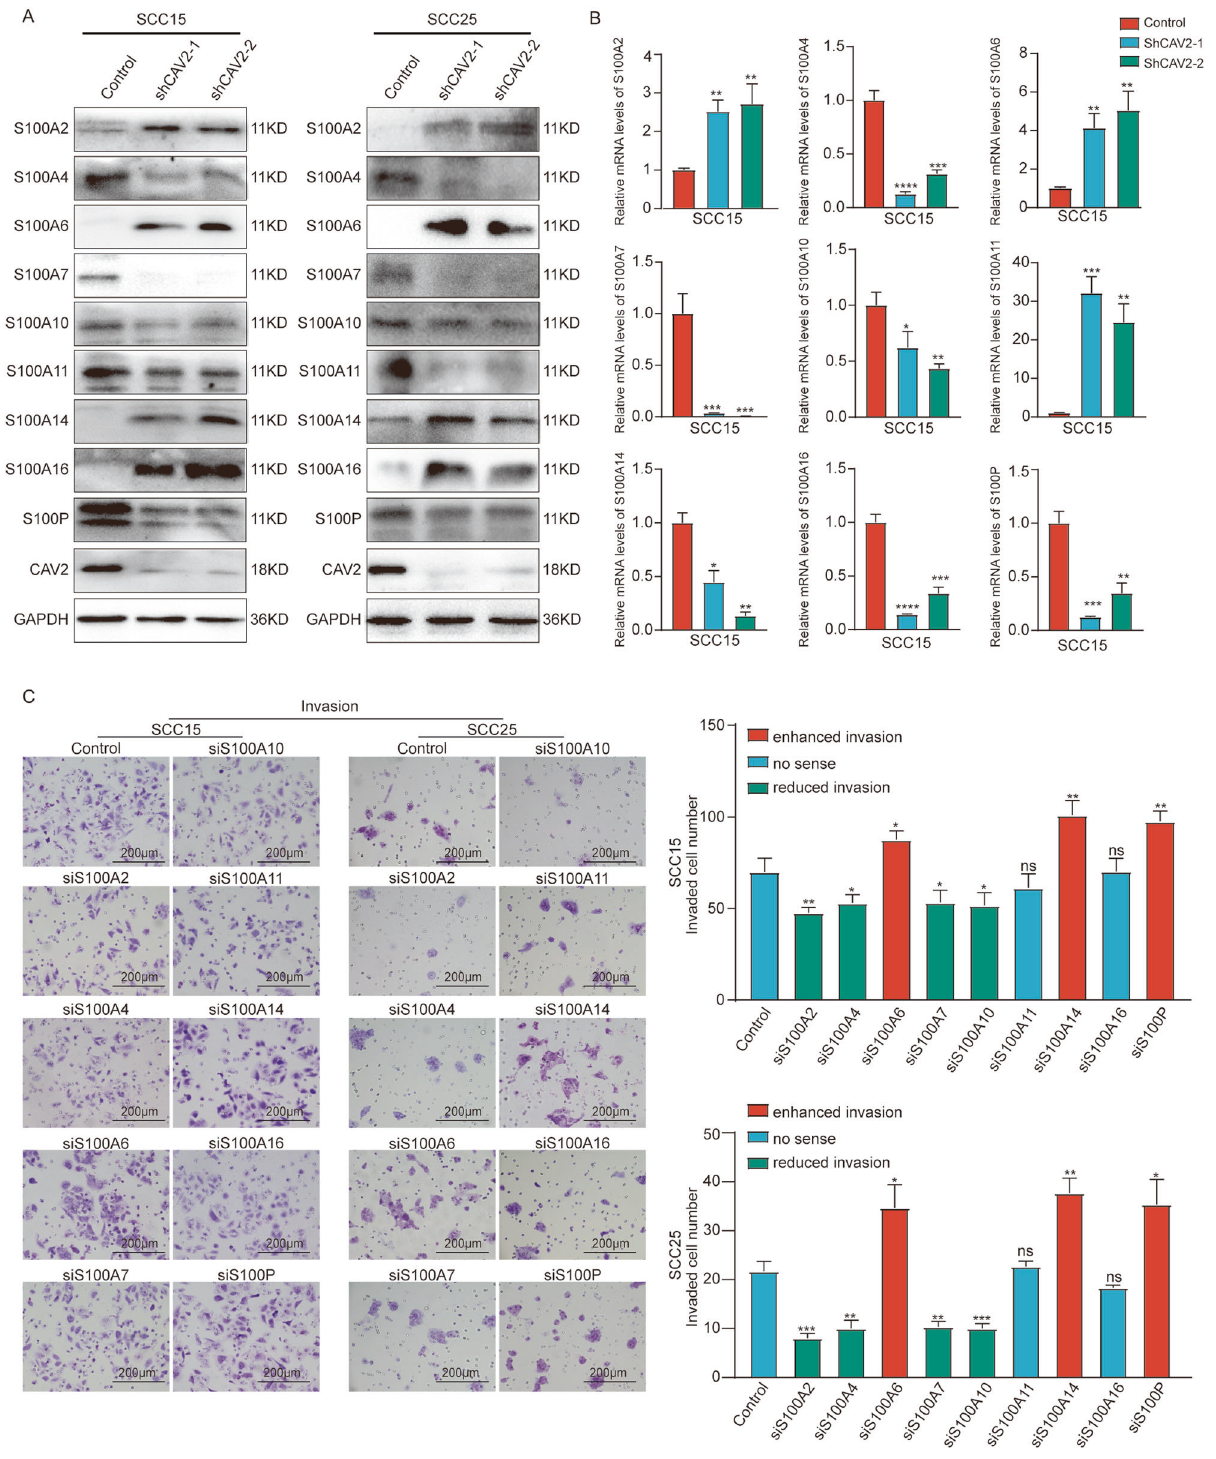
Fig. 3 The S100 protein family affects HNSCC metastasis and is regulated by CAV2. A The expression of S100 family proteins in CAV2- control and CAV2-knockdown (shCAV2-1, shCAV2-2) SCC15 and SCC25 HNSCC cell lines was evaluated by immunoblotting. B The expression of S100 family proteins in CAV2-control and CAV2-knockdown (shCAV2-1, shCAV2-2) SCC15 cell lines was evaluated by RT – qPCR. C Alterations in the invasive ability of SCC15 and SCC25 cells following siRNA interference of S100 protein family members. The invasive ability of SCC15 and SCC25 cells was detected using Transwell assays. *, **, *** and **** indicate p < 0.05, p < 0.01, p < 0.001 and p < 0.0001, Moreover, knockout of CAV2 suppressed tumor metastasis, and angiogenesis [23]. In a study aiming to identify the functional RNA-seq and bioinformatics analyses indicated that CAV2-related genes and genetic variants associated with the prognosis of mRNAs were mainly enriched in pathways involved in metastasis pancreatic ductal adenocarcinoma in 1070 patients, CAV2 was [24]. However, this study did not further evaluate the mechanism found to be upregulated and inversely associated with prognosis.